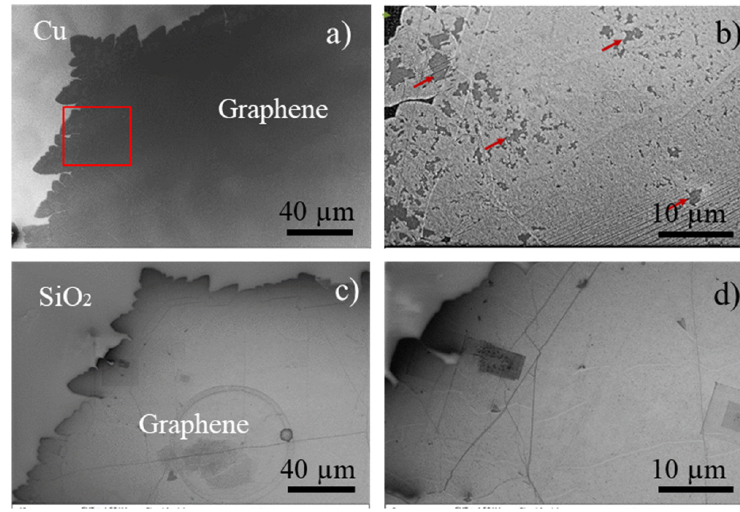
Figure 4. SEM images of graphene samples with post growth annealing ( a , b ) before transfer, ( b ) magnification of red square in panel a, red arrows pointing the unoxydized Cu areas, ( c , d ) same area after transfer, the graphene is homogeneous.